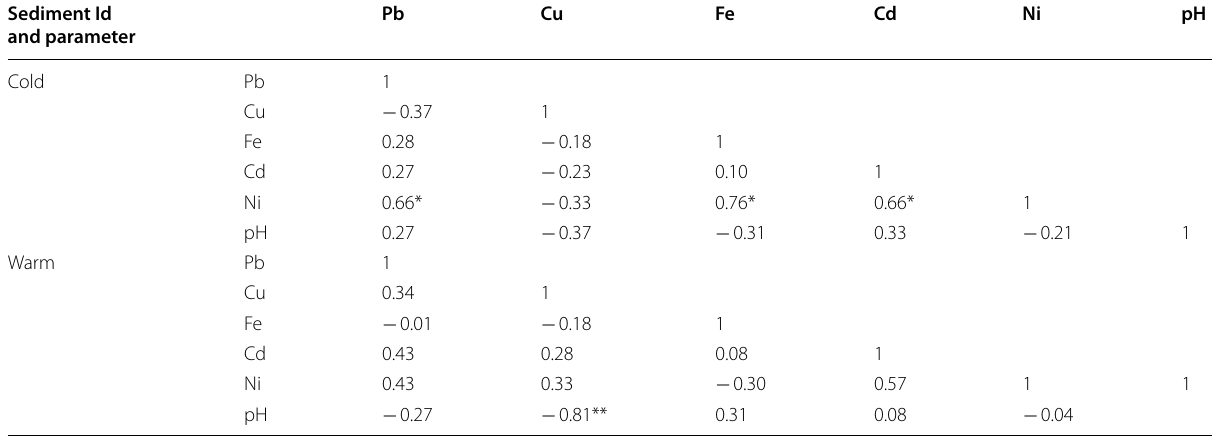
Table 5 Correlation analysis for metals in the warm and cold springs sediments * P < 0.05 ** P < 0.01 Sediment Id and parameter